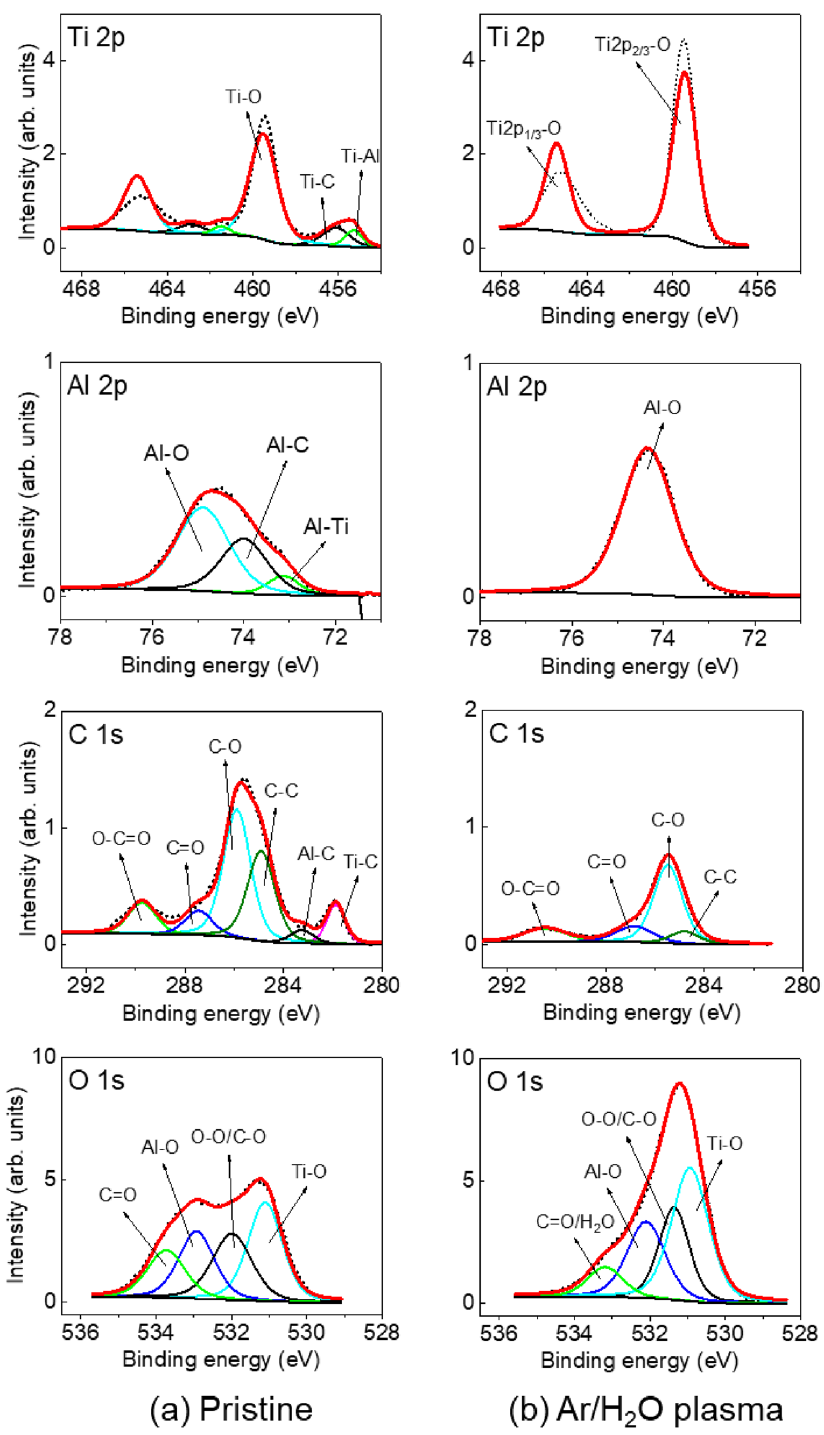
Figure 5. XPS spectra obtained on the surface of TiAlC film ( a ) before and ( b ) after exposure to Ar/H 2 O plasma at 100 W and 0.64